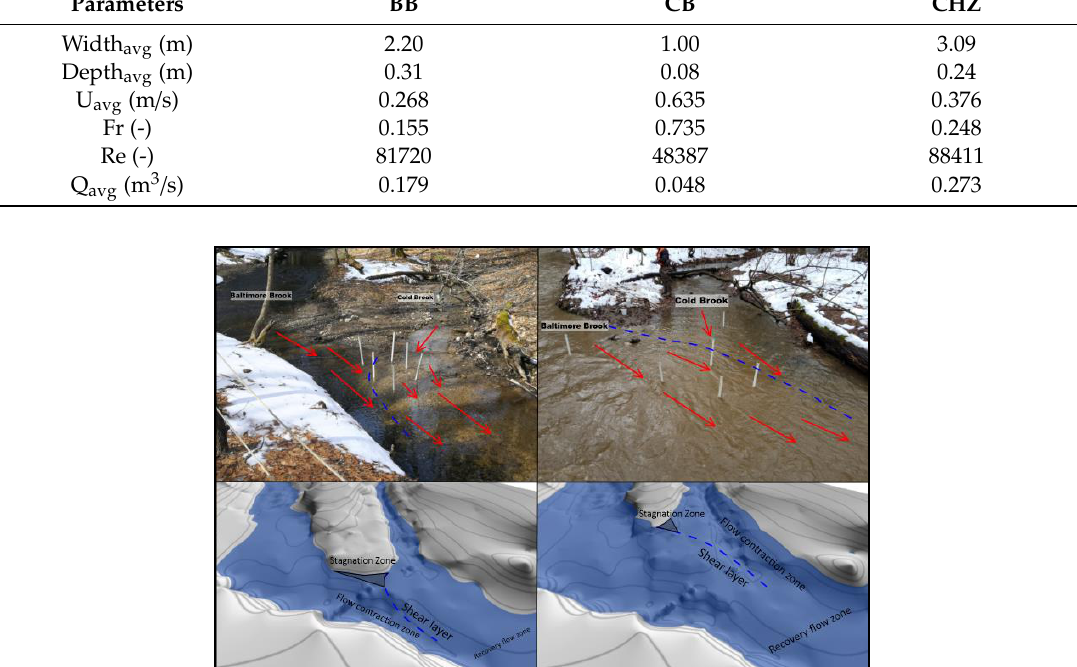
Figure 6. Topography of watershed and riverbeds about the confluence zone, with black solid contour lines showing elevation above sea level (m). Black dotted lines delineate the active channel during low flow, and the red dotted ellipse delineates a scour hole. 4.1.2. Bed Morphology The confluence was characterized by low-gradient water surface slopes, with slightly higher slopes in the CB tributary in the 5 m upstream the junction. The area between BB and CB was abundant in outwash sediments and partially submerged during high-flow discharge event (i.e., in December after a sudden snow melt, Figure 5) complicating the localization of the BB and CB riverbanks (Figure 6). The deepest pool was found in BB, at a scour hole of approximately 40 – 50 cm wide, along the outer bank as common in pool-riffle rivers [41 – 43], while CB and the CHZ depths were mostly without pool and averaged 5 – 10 cm. Sediment scour was located in the BB pool and